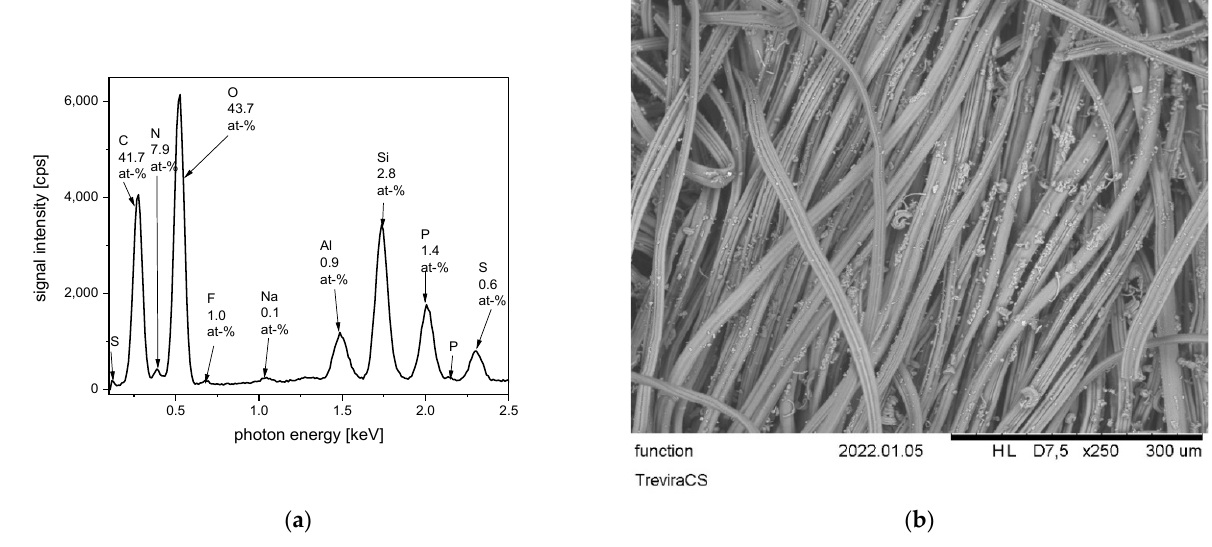
Figure 23. Commercially available fabric made from functional cellulosic fibers Arabon—( a ) EDS spectrum; ( b ) SEM image.